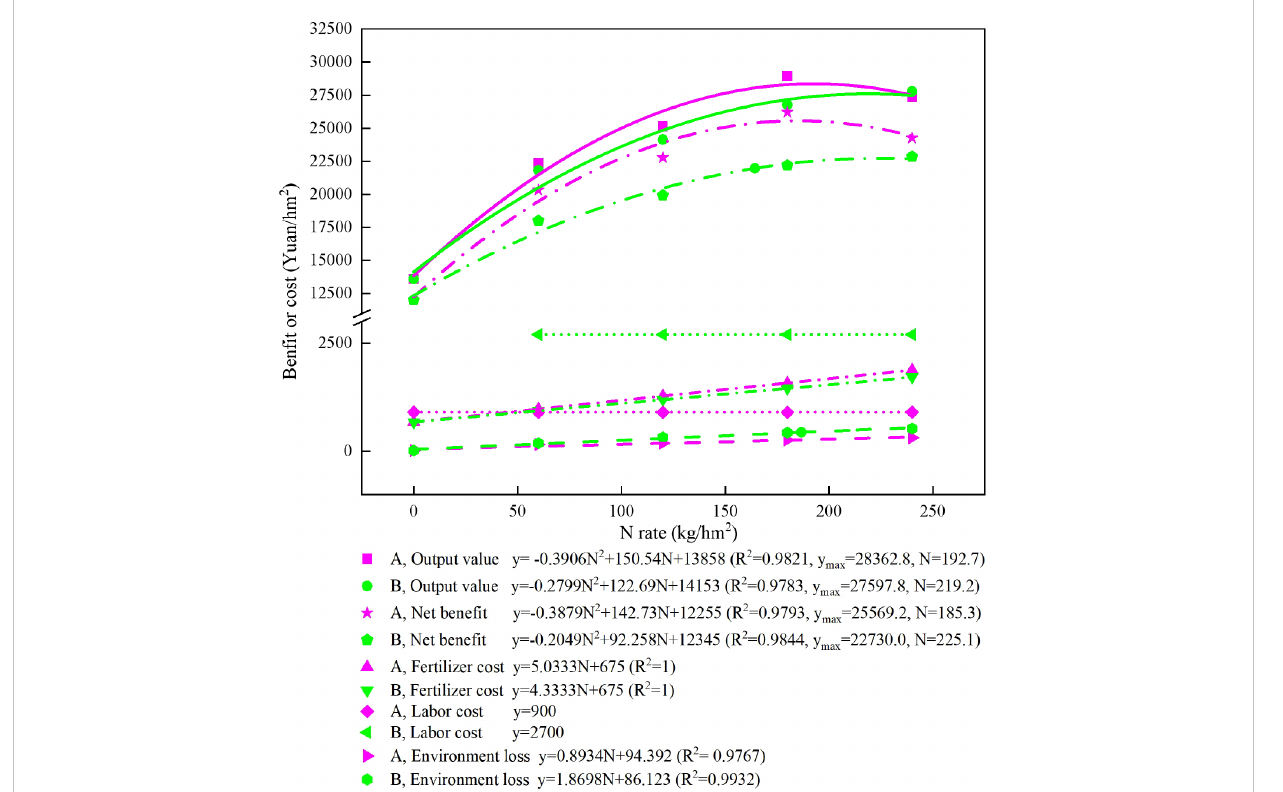
FIGURE 8 Output value, net bene fi t, fertilizer cost, labor cost, and environmental loss under the blended CRN treatments (red graph) and conventional N fertilizer treatments (green graph) with applied N rates of 0, 60, 120, 180, and 240 kg/hm 2 in the 2019 rice